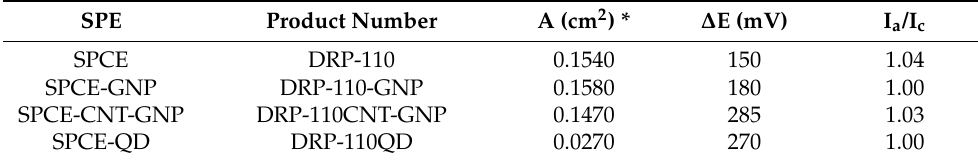
Table 3. Electrochemical properties of tested commercially available SPEs. SPE Product Number A (cm 2 ) * ∆ E (mV) I a /I c SPCE DRP-110 0.1540 150 1.04 SPCE-GNP DRP-110-GNP 0.1580 180 1.00 SPCE-CNT-GNP DRP-110CNT-GNP 0.1470 285 1.03 SPCE-QD DRP-110QD 0.0270 270